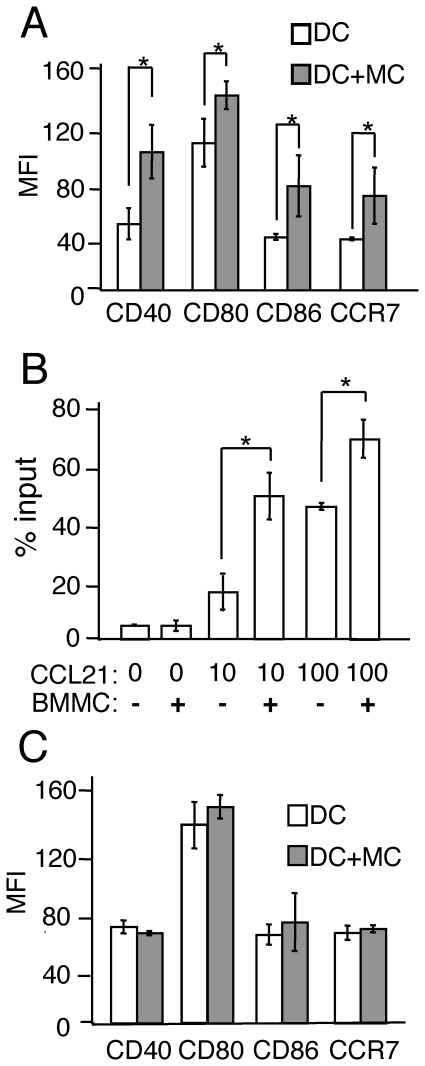
BMMCs promote the maturation and chemotactic activity of BMDCs via direct cell interaction.(A) The expression levels of CD40, CD80, CD86 and CCR7 on BMDCs cultured with or without BMMCs for 24 h. (B) Mobility of BMMCs to CCL21. BMMCs with or without BMDCs were applied to the upper chamber of a transwell without coating for 3 h. The numbers of MHC class II+ cells in the lower chamber, identified as migrating DCs, were counted by means of flow cytometry. (C) The expression levels of CD40, CD80, CD86 and CCR7 on BMDCs cultured with or without BMMCs separately by using transwell culture plates for 24 h. All data are presented as the mean ± SD and are representative of three experiments. *, P<0.05 versus a corresponding group.